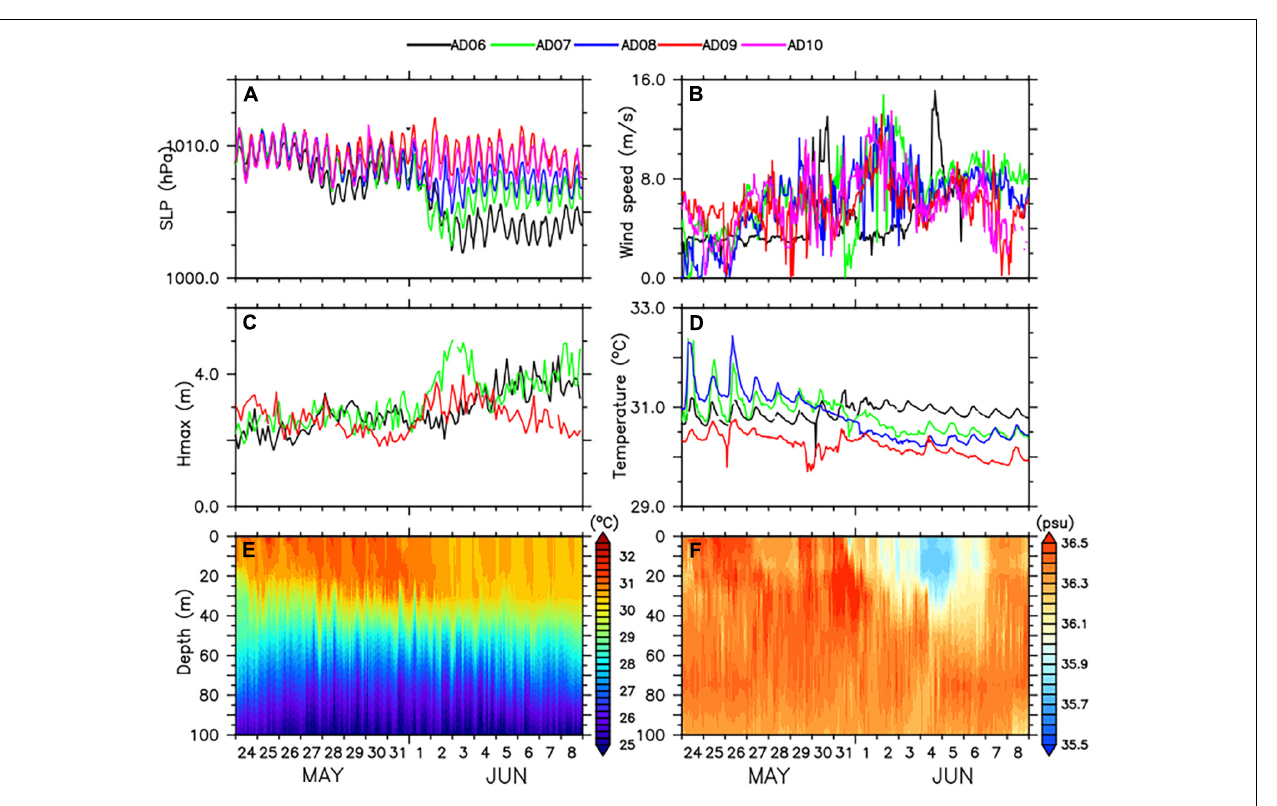
FIGURE 8 | Time series observations of (A) Sea level pressure, (B) Wind speed (C) Height of highest wave, (D) SST, (E) temperature profile at AD07, and (F) salinity profile at AD07 during the passage of Cyclone Nisarga in